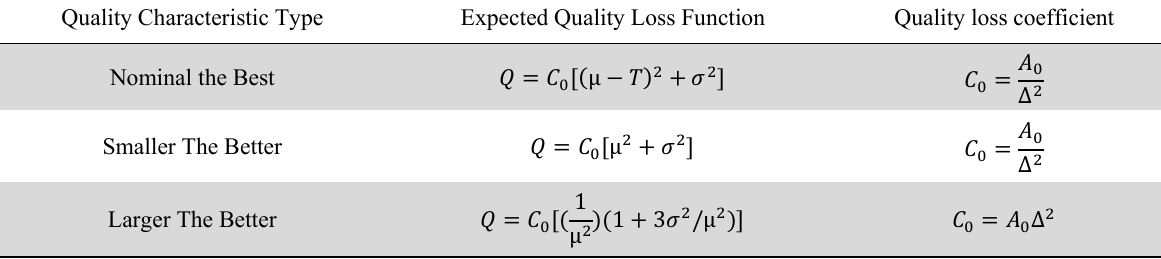
Taguchi’s approach on quality loss function Quality Characteristic